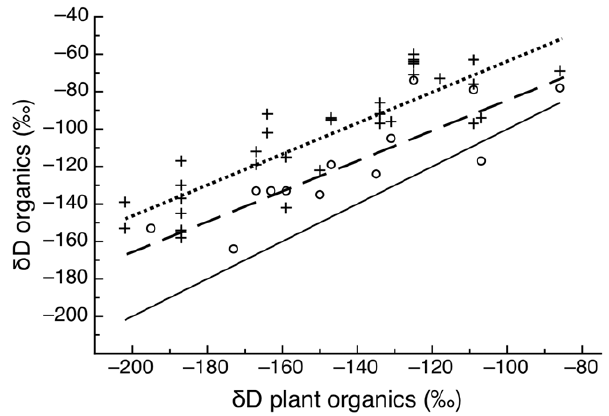
Figure 3. The d D values of moth (open circles, barred line) and caterpillar (plus ‘ + ’ signs, dotted line) tissues were linearly related to those of plant tissues and had a common slope. Note that moth organic material was significantly depleted in deuterium relative to that of caterpillars.